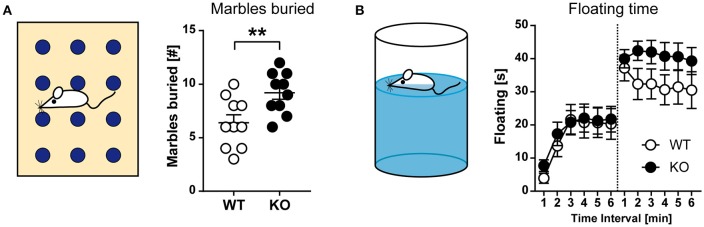
Behavioral characterization of HCN3−/− mice (part 2). (A) Marble burying test. Schematic of the testing environment (left), where mice exposed to a cage containing 12 identical glass marbles. HCN3−/− mice buried more marbles as compared to wild type littermates during a 30 min exposure time period (right). (B) Forced swimming test. Schematic of the testing environment (left). Mice are placed in an inescapable cylinder filled with water and the time spent floating (immobile) is measured. Mice were exposed to the forced swim test for 6 min on two consecutive days. HCN3−/− animals tended to spend more time floating on the second testing day (right). All values are Mean ± SEM, **p < 0.01.